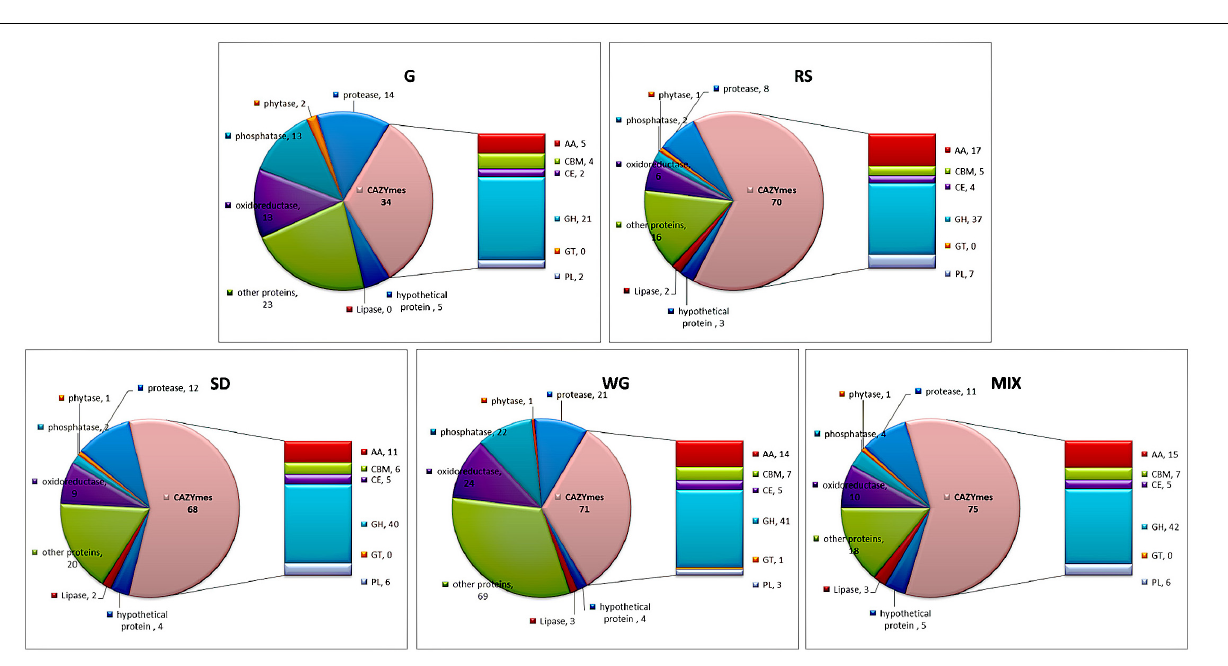
FIGURE 2 | Functional classification of the secretome of Morchella importuna in five different culture media. G, CYM medium; RS, glucose-free CYM containing 2% rice straw powder; SD, glucose-free CYM containing 2% sawdust powder; WG, glucose-free CYM containing 2% wheat grain powder; MIX, media containing equal proportions of rice straw, sawdust, and wheat grain